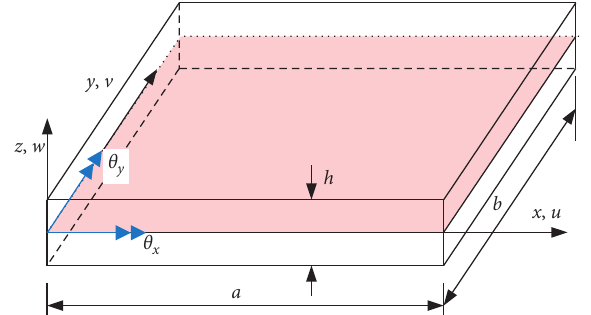
Figure 1: Positive directions of the deflection and two